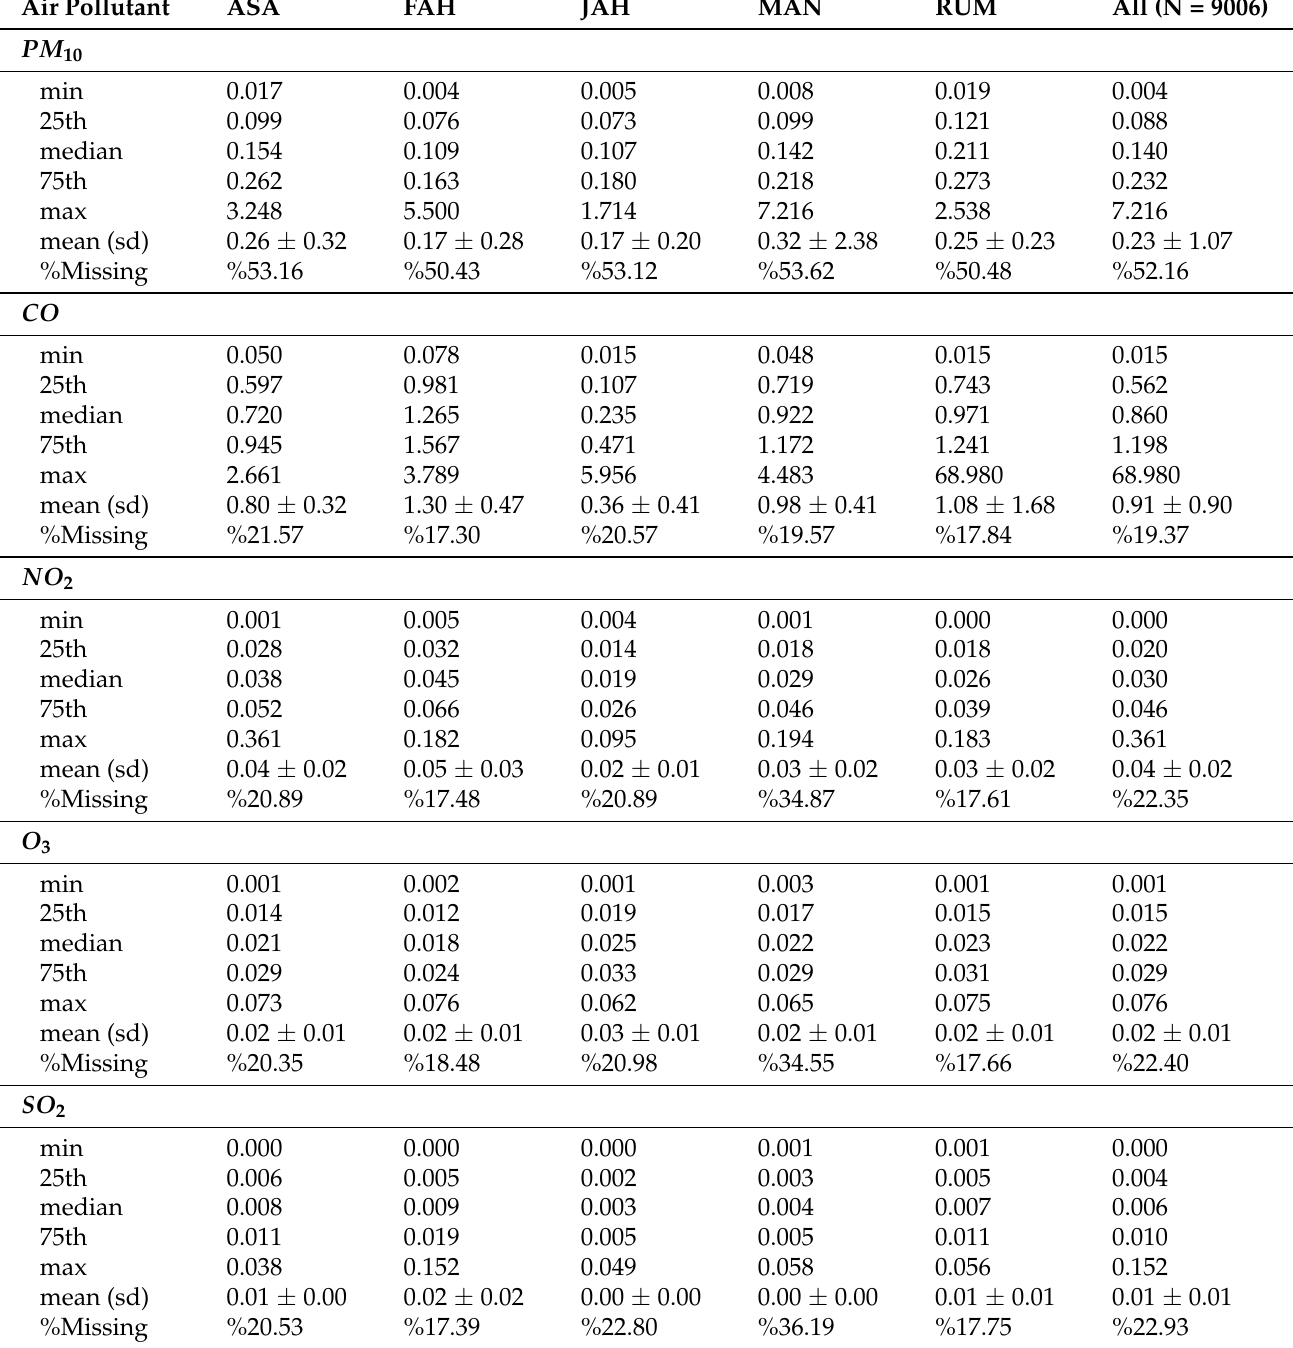
Table 2. Distribution of Kuwait ambient air pollution exposure during 2012–2017. The total daily observations for ASA are N = 1779; for FAH, N = 1820; for JAH, N = 1819; for MAN, N = 1777; and, for RUM, N =